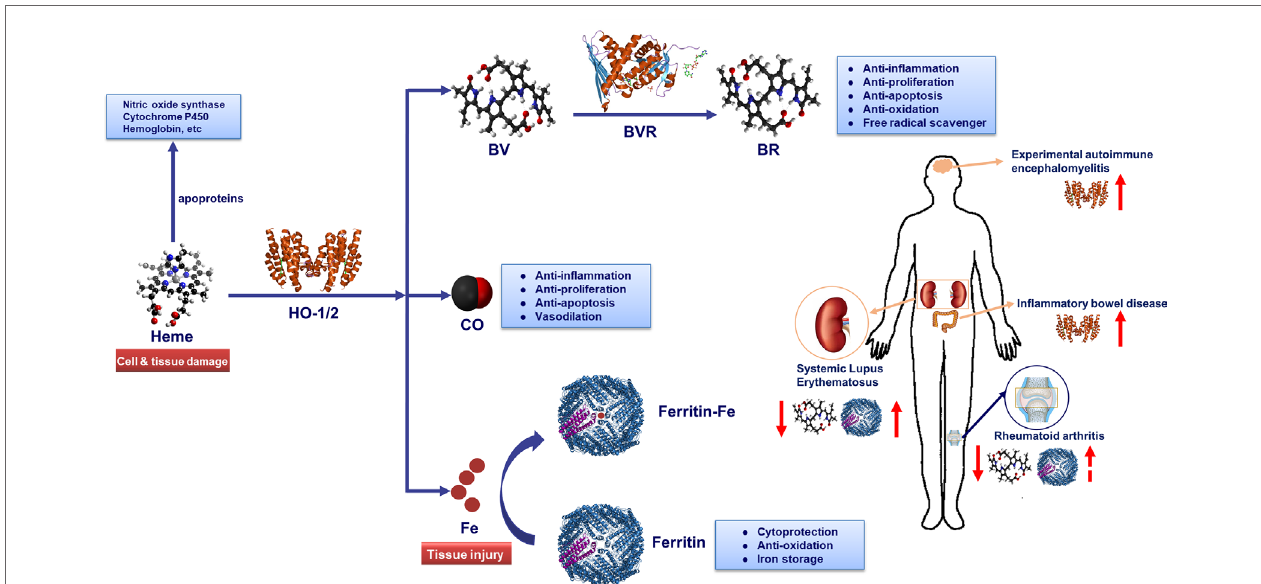
FIGURE 1 | Heme metabolic pathway. Heme oxygenase (HO) catabolizes free heme into biliverdin (BV), carbon monoxide (CO) and Fe 2+ . Biliverdin (BV) is transformed into bilirubin (BR) by biliverdin reductase (BVR) enzyme. Fe 2+ can be bound by the iron storage protein ferritin. The heme molecule provides a multitude of crucial biological functions in the form of various apo-heme proteins like hemoglobin, nitric oxide synthase, and cytochromes. HO-1-derived metabolite CO could exert anti-inflammatory, anti-proliferation, anti-apoptosis and vasodilation effects in immune system. Similarly, BR could play a key role in anti-inflammation, anti- proliferation, anti-apoptosis, anti-oxidation and free radical scavenger. Additionally, iron-induced ferritin could play a cytoprotective, anti-oxidative and iron storage effect. Notably, HO-1 and serum BR/BV can be used as biomarker for autoimmune diseases. While, the potential of serum ferritin as a biomarker in systemic lupus erythematosus (SLE) or rheumatoid arthritis (RA) diagnosis process needs further verification. Serum ferritin levels are positively correlated with disease activity index in SLE and RA patients. In addition, the serum levels in patients with SLE and RA are lower than healthy controls and were inversely correlated with disease severity. In inflammatory bowel disease (IBD) and experimental autoimmune encephalomyelitis (EAE) diseases, the level of HO-1 in lesions rises along the disease course, and the induction of HO-1 could improve diseases